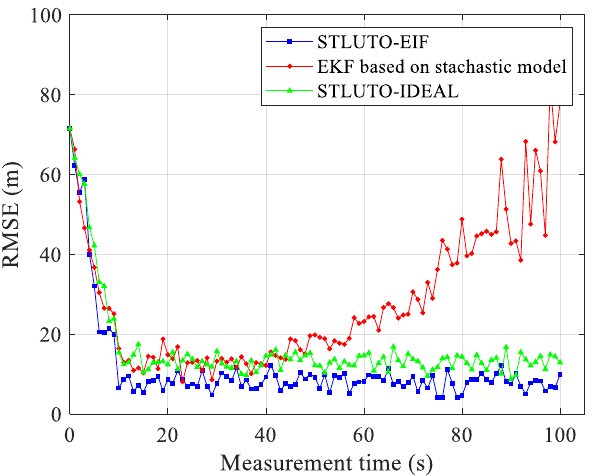
Figure 6. Root mean squared error (RMSE) errors of target localization for the moving target with